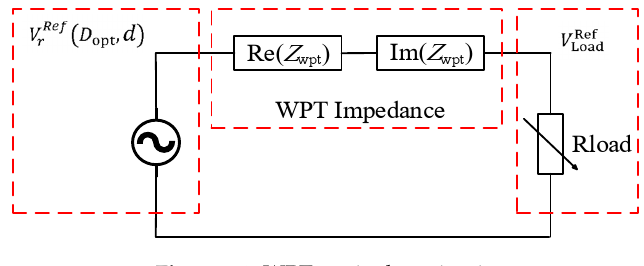
Figure 14. WPT equivalent circuit.